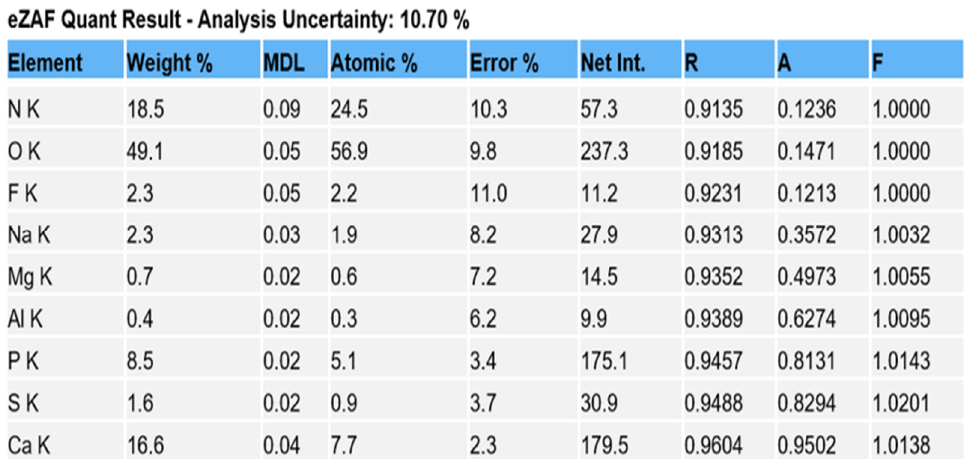
Figure 13. Data from SRP-only specimen generated for the elements of interest, expressed as Weight % and Atomic %. Both represent the relative concentration of the element in the sample. Atomic % is calculated by dividing the element Weight % by its atomic weight. Note the analysis uncertainty of 10.70% indicating the error of measurement which is influenced by the irregular topography of the root surface.